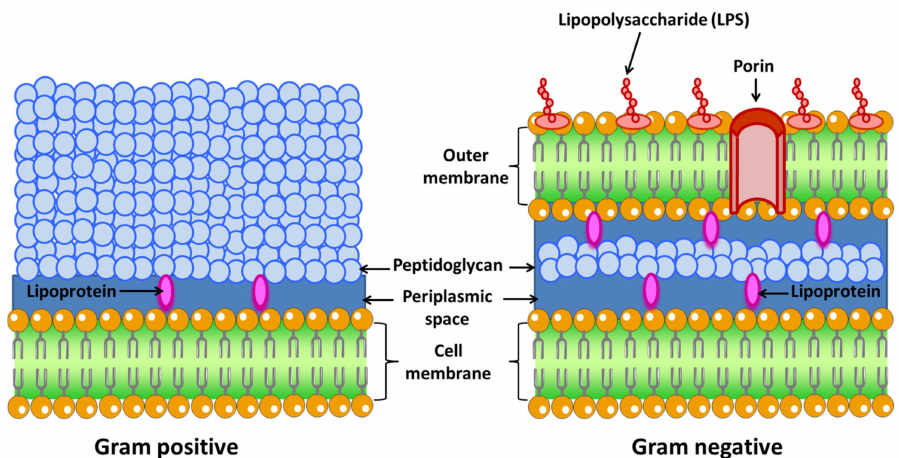
Figure 2. Differences between Gram-negative and Gram-positive